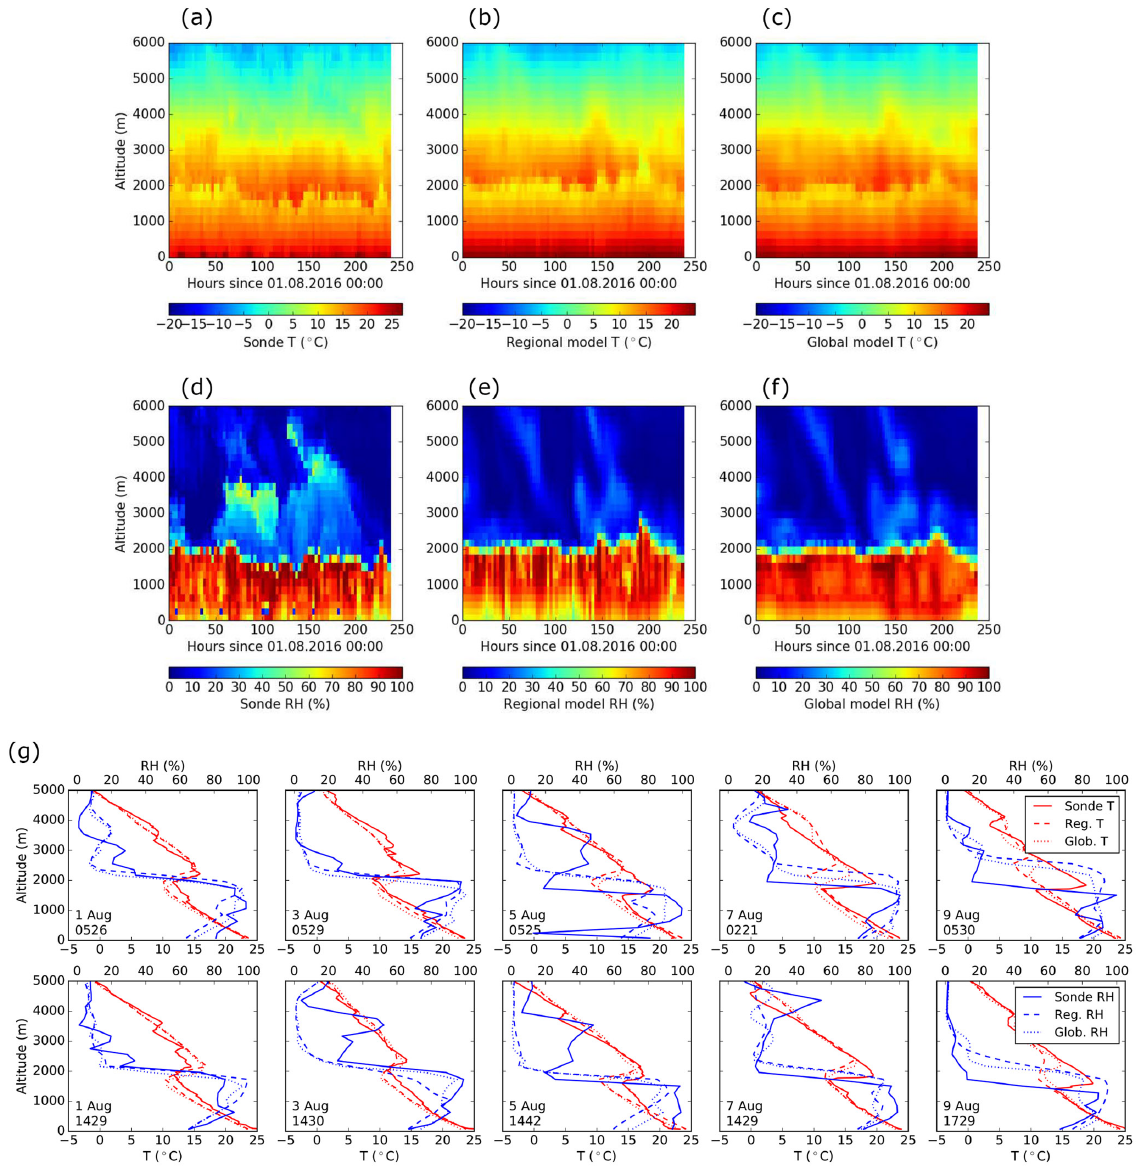
Figure 5. Temperature and relative humidity at Ascension Island compared with ARM radiosondes (Holdridge et al., 2016b). The top six plots show the observed (a, d) , and the regional (b, e) and global (c, f) model time series of temperature (a–f) and relative humidity (g) . The next five profile plots are representative of night-time, and the bottom five of the afternoon, on 1, 3, 5, 7 and 9 August. The date and time of the sonde release is shown on the bottom